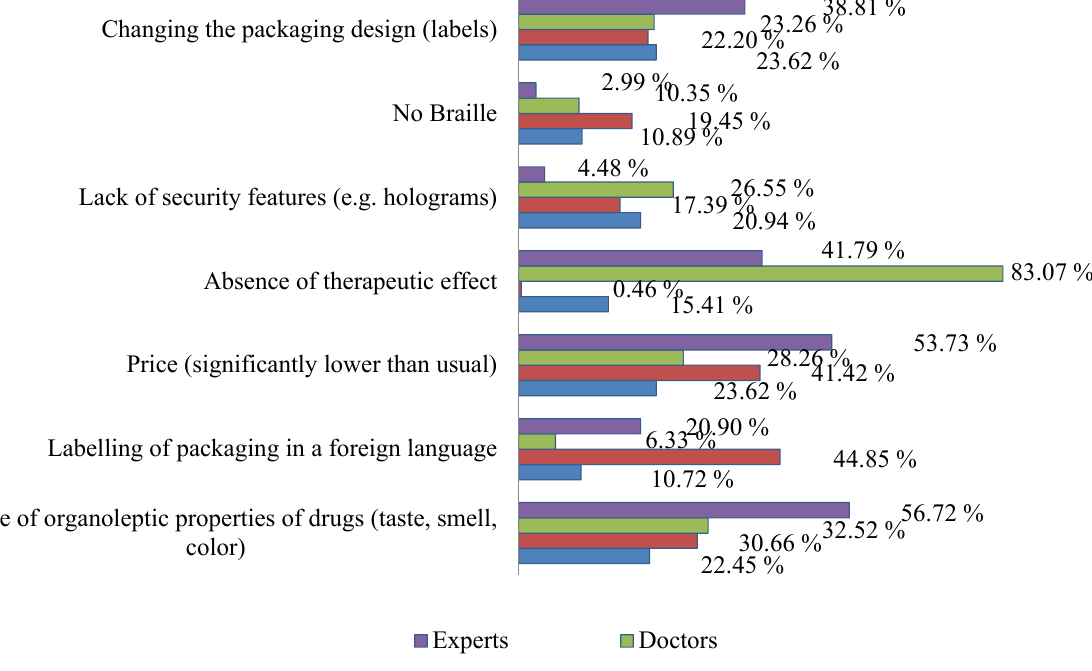
Fig. 2. The results of the survey on the main signs of drug